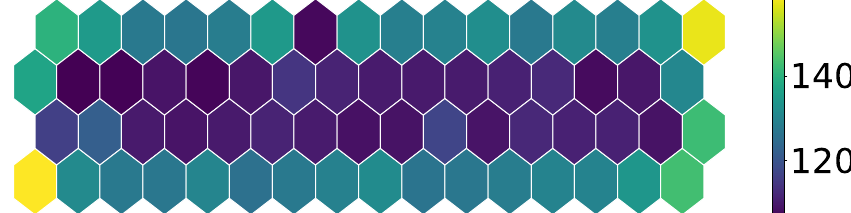
Figure 9. Hitmap of the seed pixels for the 20µm matrix.